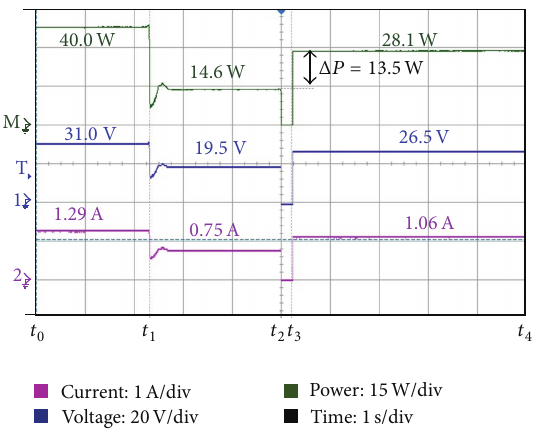
Figure 12: Experimental results: CF.01-CF.02.